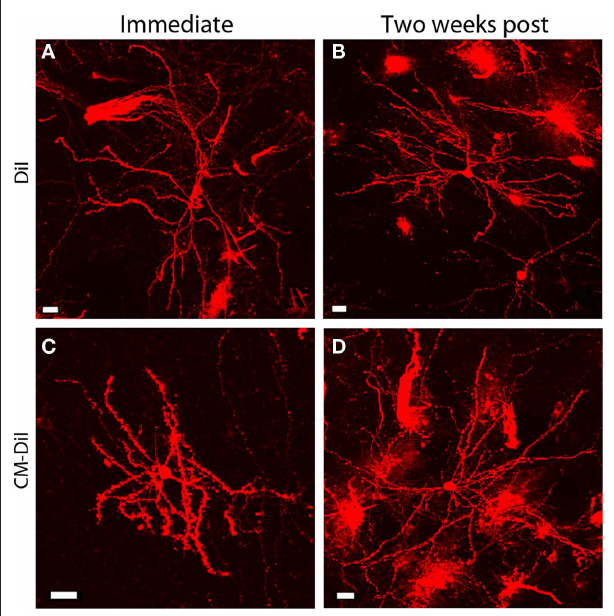
Figure 6 | Whole cell images of permeabilized Dii and CM-Dii labeled tissues. DiI labeled cell imaged (A) immediately or (B) 2 weeks following tissue mounting. Permeabilized CM-DiI labeled cell imaged (C) immediately or (D) 2 weeks following tissue mounting. Images illustrate micro-carrier clumps and the axonal labeling occasionally seen with DiOlistic labeling. Scale bar is 20 μm.